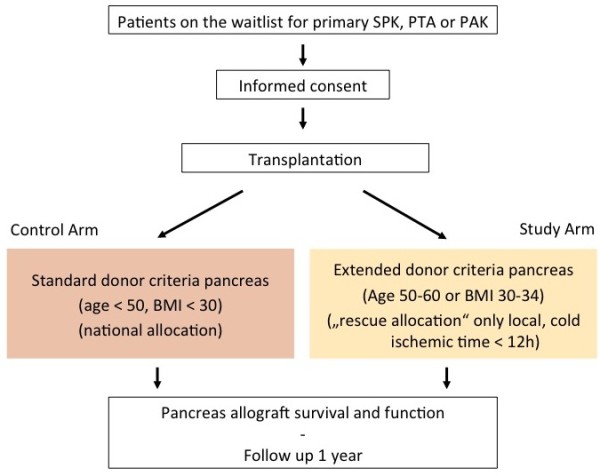
Inclusion scheme.